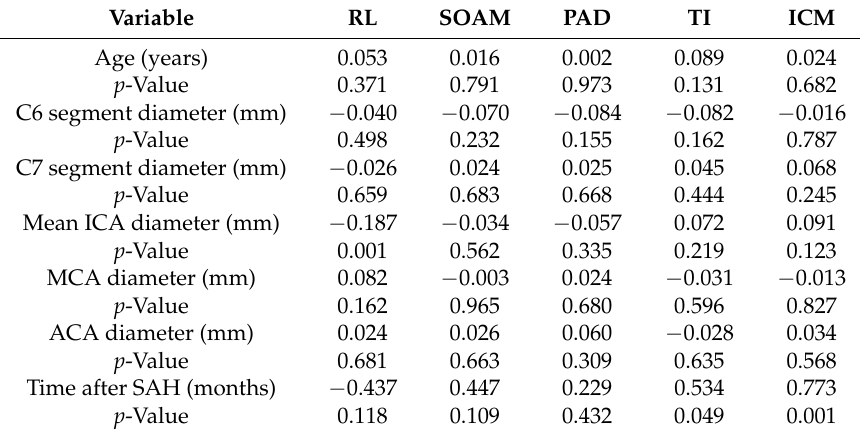
Table 3. Correlation of tortuosity descriptors and continuous